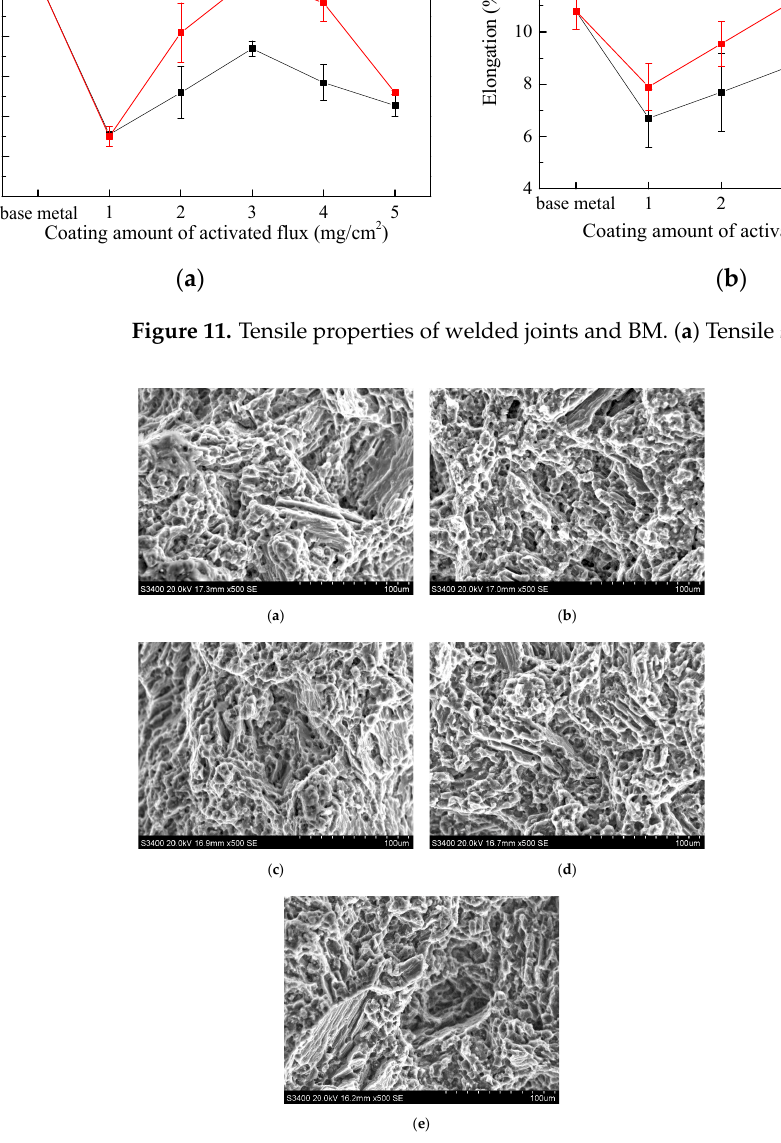
Figure 12. Fracture morphology under different amounts of activated flux ( a ) 1 mg/cm 2 ; ( b ) 2 mg/cm 2 ; ( c ) 3 mg/cm 2 ; ( d ) 4 mg/cm 2 ( e ) 5 mg/cm 2 . 4. Conclusions The effect of the longitudinal alternating magnetic field and TiO 2 flux on microstructure and mechanical properties of the AZ91 magnesium alloy welded joint was investigated. The conclusions are as follows: (1) When the coating amount of activated flux is 3 mg/cm 2 , the highest penetration of the welded joint is obtained, which is 141% of that without activated flux. Meanwhile, the mechanical properties reach the maximum, which is tensile strength of 292 MPa, elongation of 11.2%, and weld zone hardness of 75.6 HV. (2) The combined effect of TiO 2 flux and magnetic field makes the liquid metal spiral downward, which makes the movement of the molten pool more violent and the